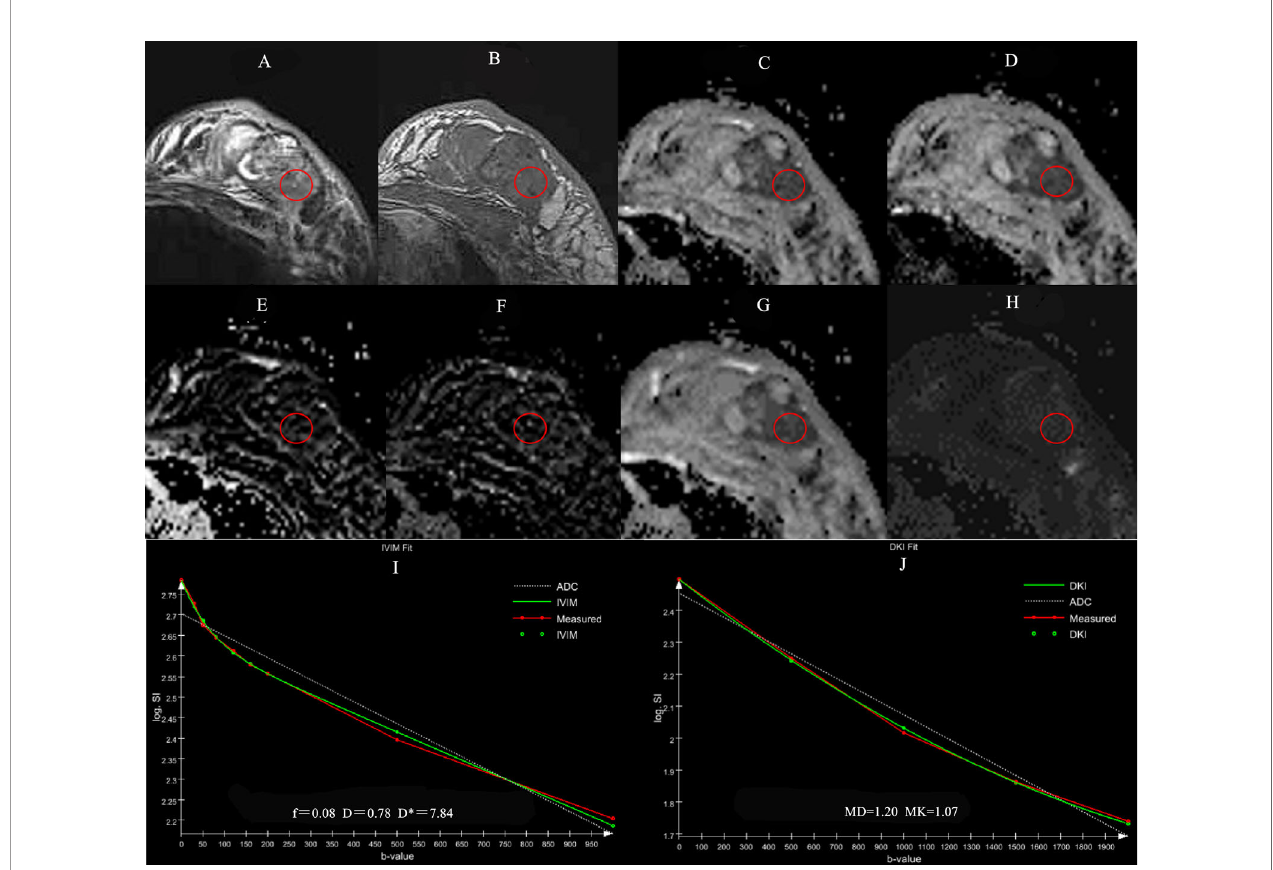
FIGURE 1 | A 56-year-old female patient with the left breast mass. The mass is located in outer quadrant of left breast (red round ROI), showing heterogeneous hyperintensity on TIRM (A) , hypointensity on T1WI (B) , ADC (C) , D (D) maps, isointensity on f (E) , D * (F) maps, hypointensity on MD (G) and hyperintensity on MK (H) maps. Graphs show signal intensity vs. b value fi ts in single pixels of invasive ductal carcinoma of the breast with the IVIM (I) and DKI (J)